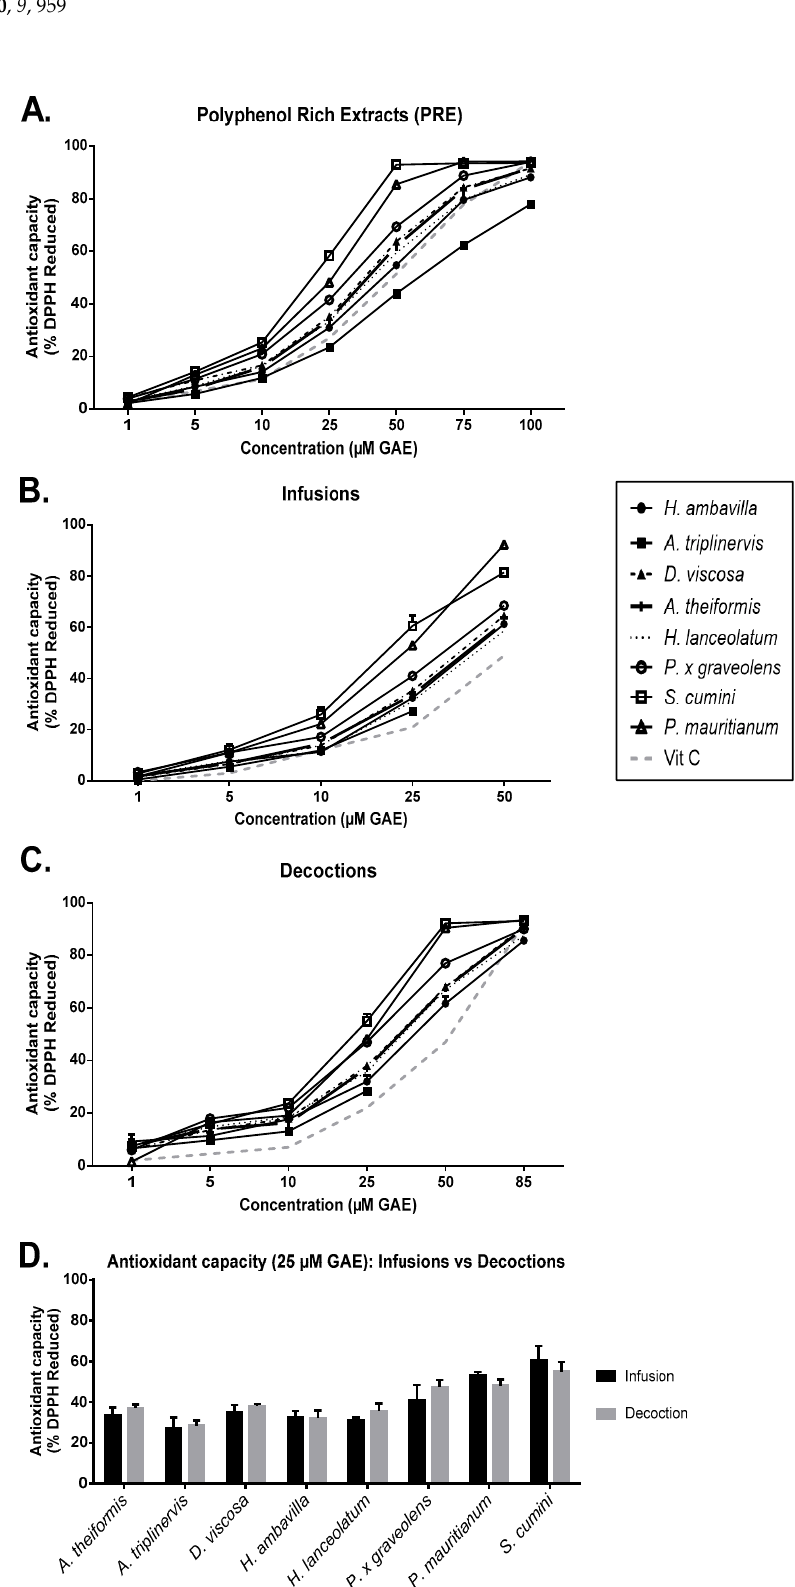
Figure 2. Antioxidant capacity of medicinal plant PRE, infusions and decoctions using DPPH assay after normalization to GAE. Dose-dependent antioxidant capacity of PRE ( A ), infusions ( B ) and decoctions ( C ) at di ff erent concentrations. ( D ) Antioxidant capacity of infusions versus decoctions at 25 µ M GAE final concentration. The radical-scavenging activity was evaluated through the DPPH colorimetric method at 517 nm. Data are means ± SEM of three independent